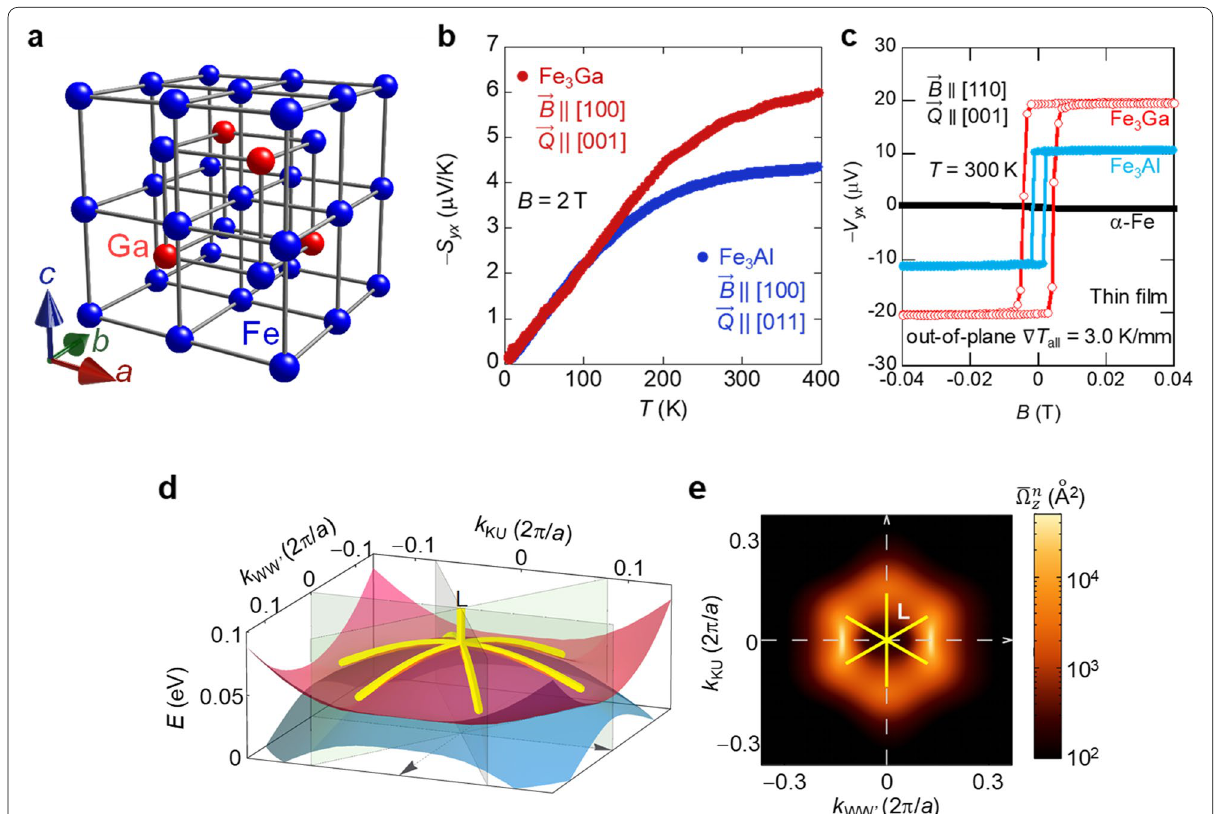
Fig. 7 Giant magneto-thermoelectric effect in nodal line semimetals [16]. a Crystal structure of cubic DO 3 Fe 3 Ga, b Temperature dependence of the anomalous Nernst coefficient - S yx of the nodal line semimetals, Fe 3 Ga and Fe 3 Al, and c Room temperature transverse EMF - V yx of Fe 3 Ga and Fe 3 Al thin films. The zero-field value is approximately 20 times larger than that of α-Fe, which has the same bcc structure as Fe 3 Ga and Fe 3 Al. d First-principles band structure of Fe 3 Ga (red and blue surfaces) and a nodal web consisting of nodal lines (yellow). e Contour plot of the fictitious magnetic field (Berry curvature) (cid:31) n z generated around the nodal web. The yellow lines in the center correspond to the nodal lines shown in d . See reference 16 for